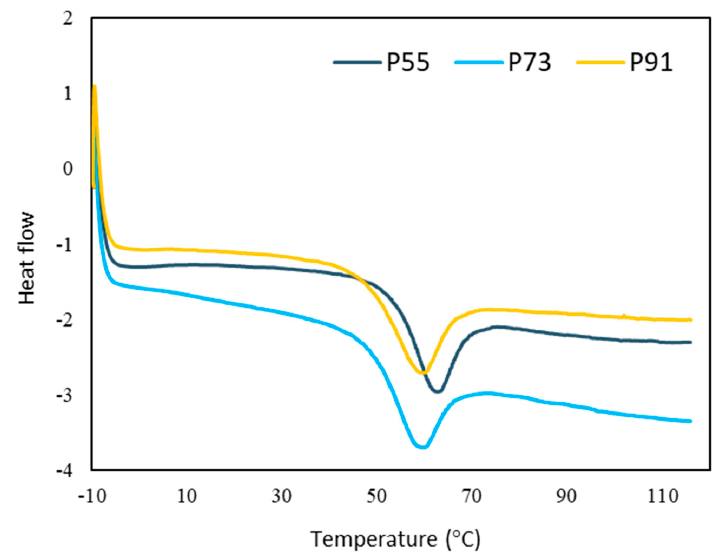
Figure 3. Glass transition temperature ( T g ) of spray-dried noni juice powders. P55, P73 and